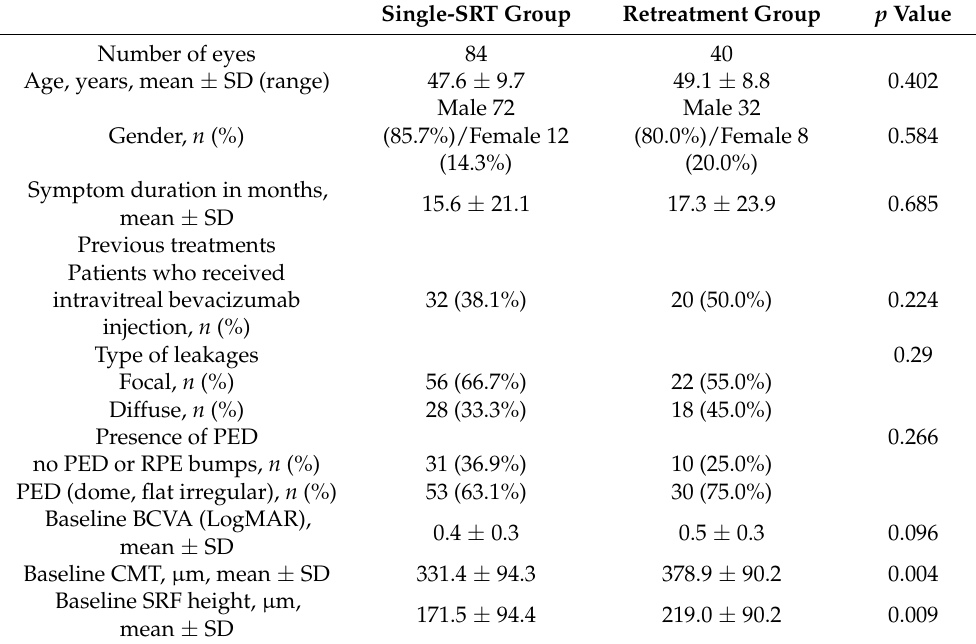
Table 5. Comparison of baseline characteristics between single-selective retina therapy group and retreatment group with chronic central serous chorioretinopathy patients who showed complete subretinal fluid resolution